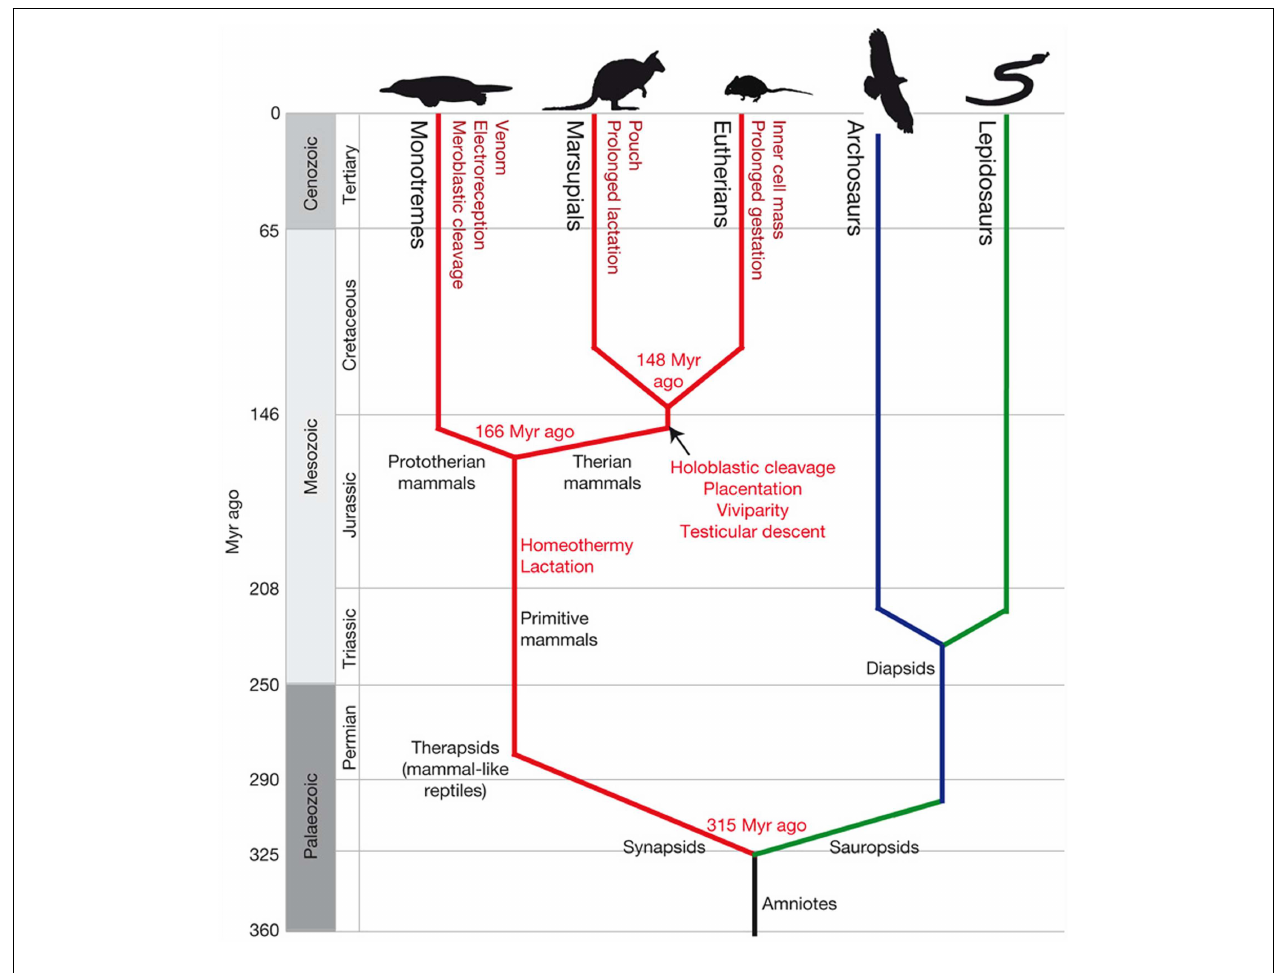
mammals with common characters split into marsupials and eutherians around 148Myr ago (dark-red text). Geological eras and periods with relative times (million years ago) are indicated on the left. Mammal lineages are in red; diapsid reptiles, shown as archosaurs (birds, crocodilians, and dinosaurs), are in blue; and lepidosaurs (snakes, lizards, and relatives) are in